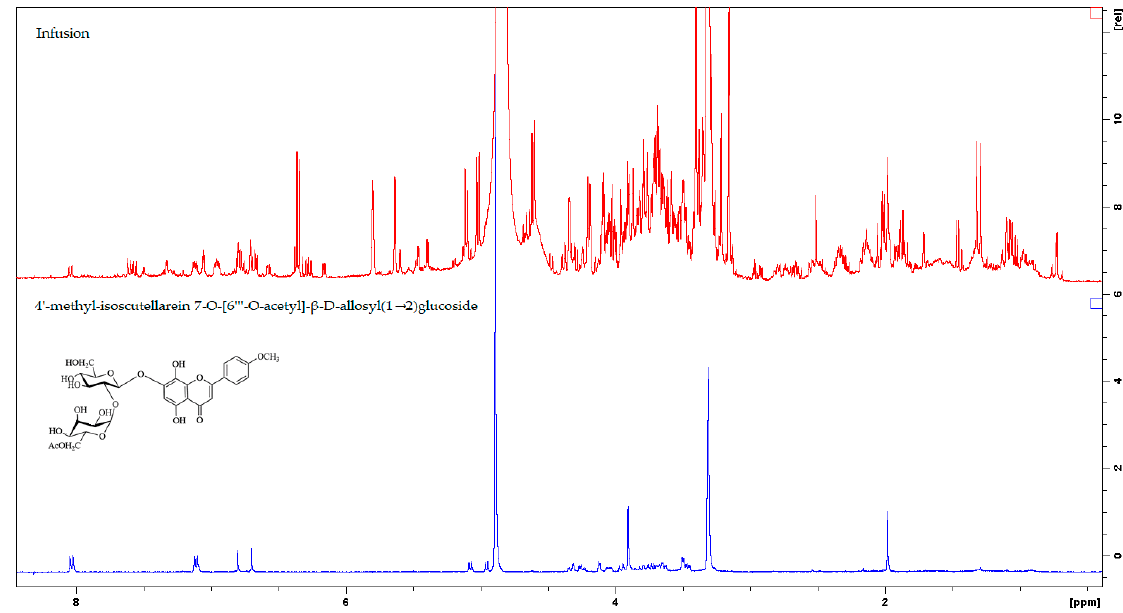
Figure 5. The overlaid 1 H-NMR spectra of the infusion of S. perfoliata subsp. perfoliata and of 4 ′ -methyl-isoscutellarein 7-O-[6’’’-O-acetyl]- β -D-allosyl(1 → 2)glucoside.